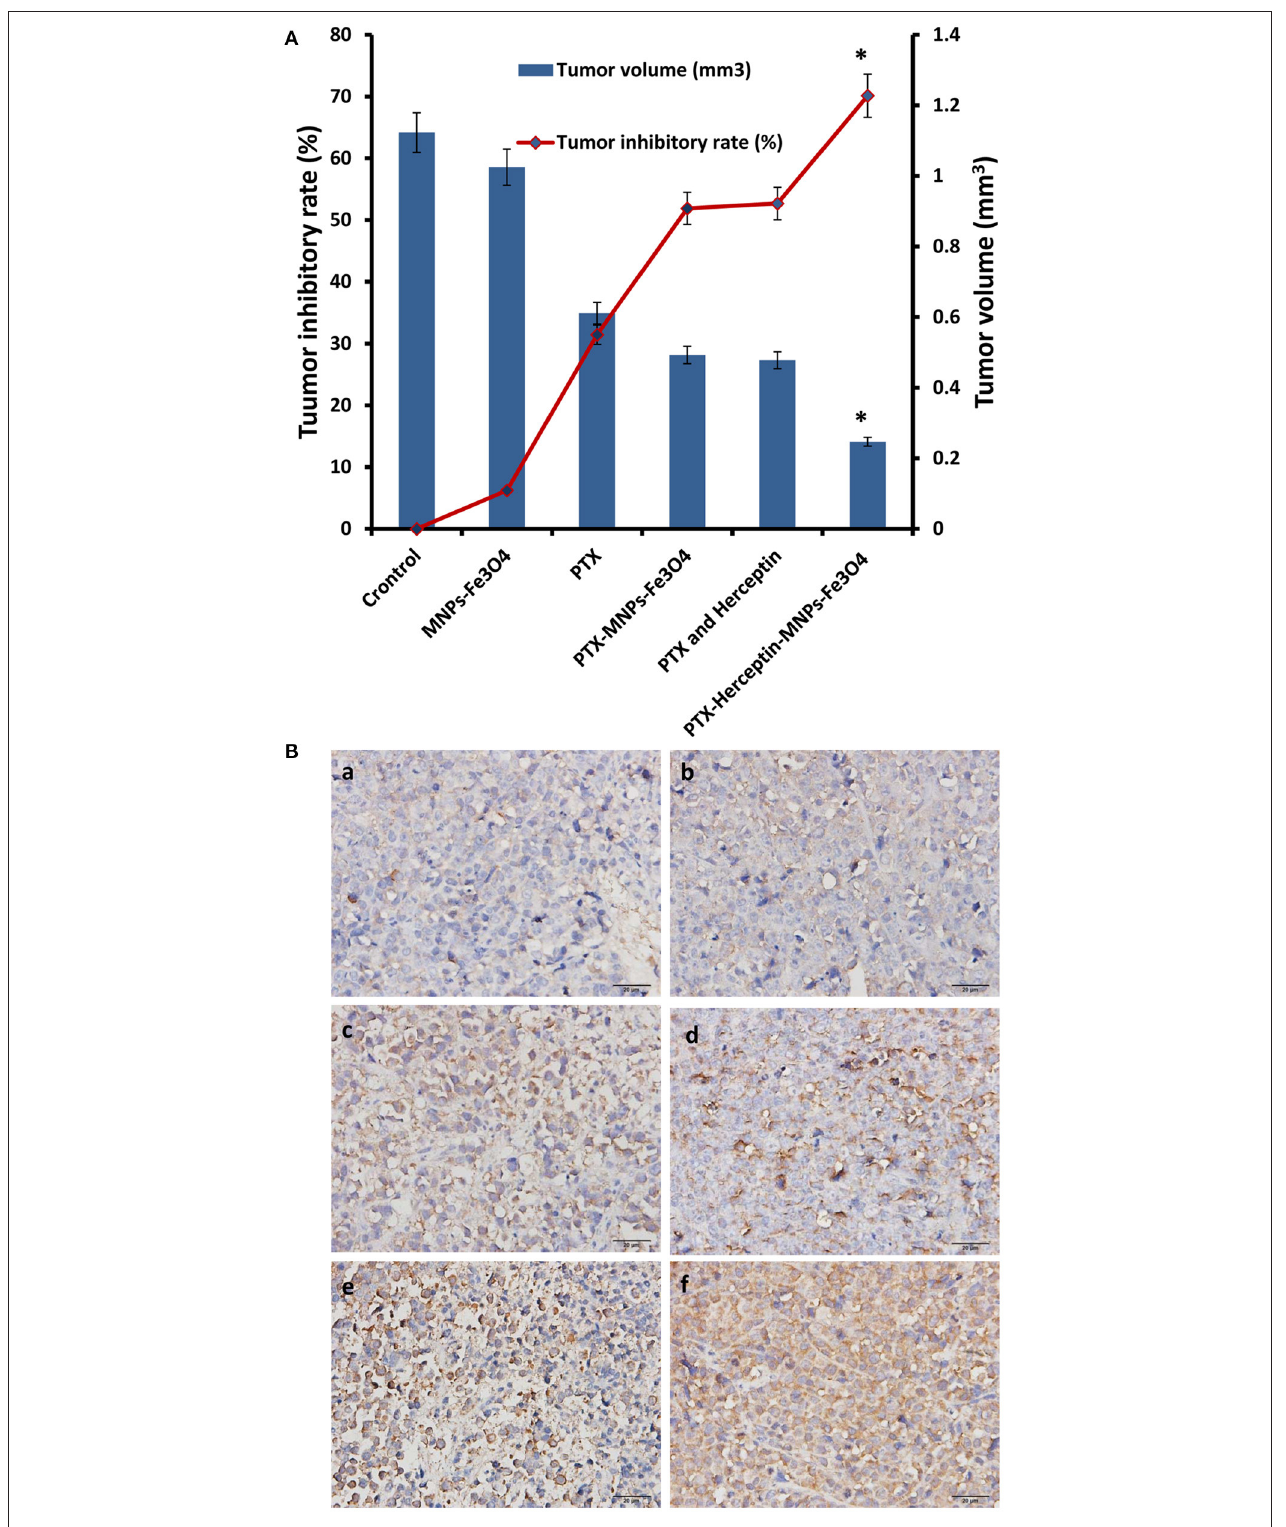
FIGURE 4 | (A) The relative tumor inhibitory rate of mice after treatment for 14 days. (B) Expression of cleaved-Caspase-3 in tumor tissues after the treatment (immunohistochemistry, × 400) of (a) Control group; (b) MNPs-Fe 3 O 4 group; (c) PTX group; (d) PTX-MNPs-Fe 3 O 4 group; (e) PTX and Herceptin group; and (f) PTX-Herceptin-MNPs-Fe 3 O 4 group. * P < 0.05 when compared with the PTX and Herceptin group.